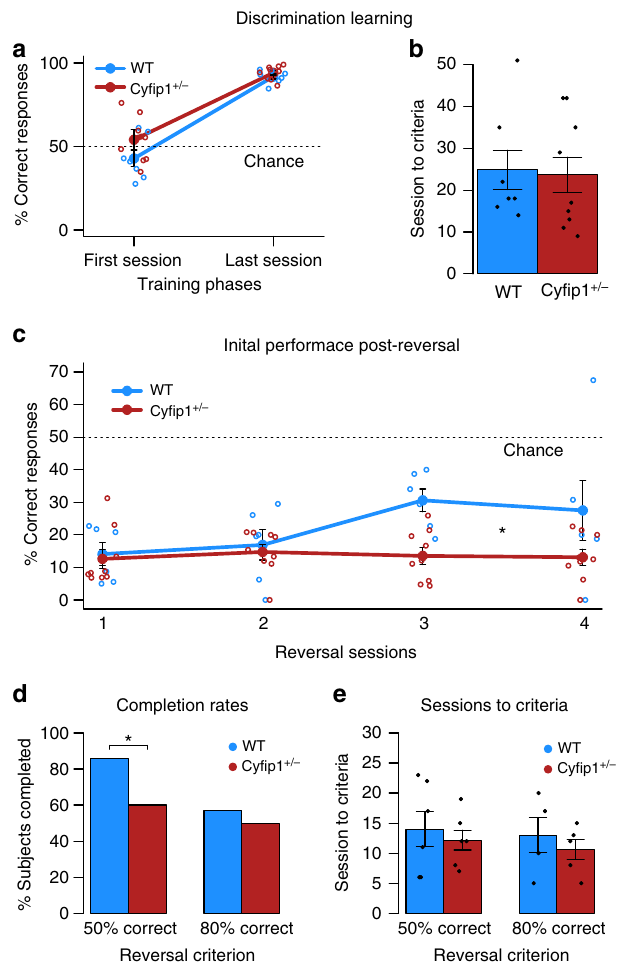
Fig. 5 Cy fi p1 haploinsuf fi cient rats show de fi cits in behavioural fl exibility in a reversal learning paradigm. WT ( n = 7) and Cy fi p1 + / − ( n = 9) rats successfully acquire the visual discrimination in the touchscreen boxes, reaching the same level of performance (% correct) a during the last session of training, and b reaching criteria in a similar number of sessions (ANOVA: F (1,14) = 0.03, p = 0.86). One Cy fi p1 + / − rat did not complete initial learning. c Cy fi p1 + / − rats show more persistent responses to the original stimulus response contingencies during the fi rst few sessions of reversal, (WT ( n = 6) and Cy fi p1 + / − ( n = 9), ANOVA: GENOTYPE X SESSION interaction, F (3,39) = 3.76,*), where one of the WT rats did not start reversal learning task. d A larger proportion of Cy fi p1 + / − rats failed to reach the 50% correct criterion during reversal than WT rats, (Chi-squared: χ 2 = 9.61,*). e However, those that do reach criteria do so in a similar number of sessions as WT rats (effect of GENOTYPE, ANOVA: 50% criteria ( F (1,10) = 0.31, p = 0.59), and 80% criteria ( F (1,7) = 0.44, p = 0.57). Data are mean ± SEM. *<0.05, **<0.01, ***<0.001. The raw number of animals completing each task can be seen in Supplementary Table